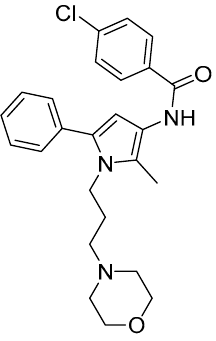
Figure 2. Structure of Compound A.